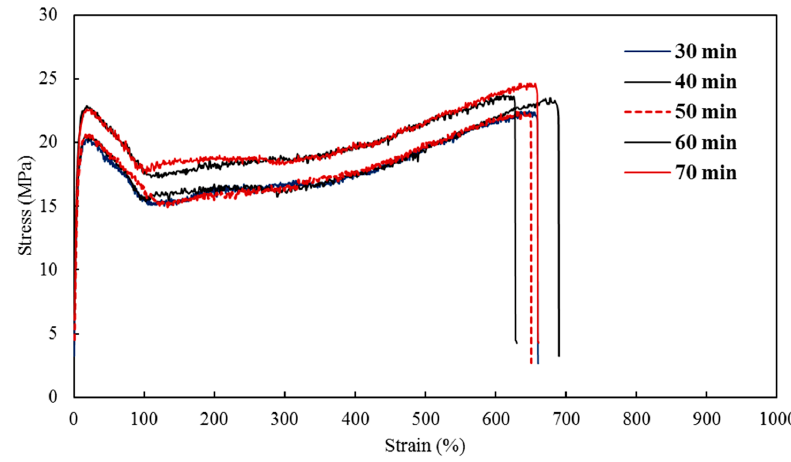
Figure 11. Stress-strain curves of injection molded nanocomposites with varying residence time.